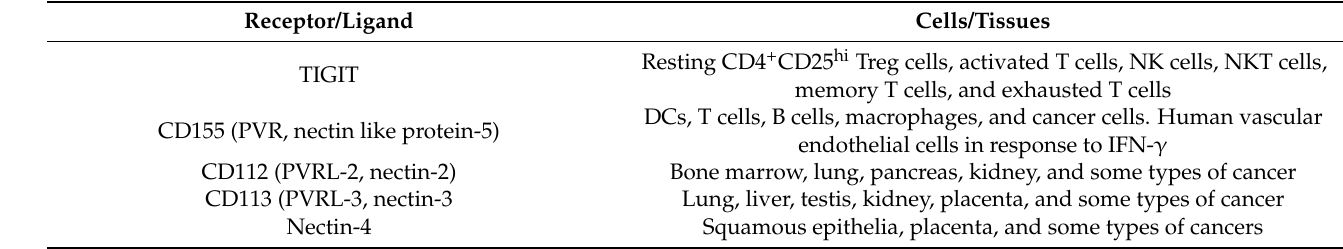
Table 1. Cells expressing TIGIT receptors and